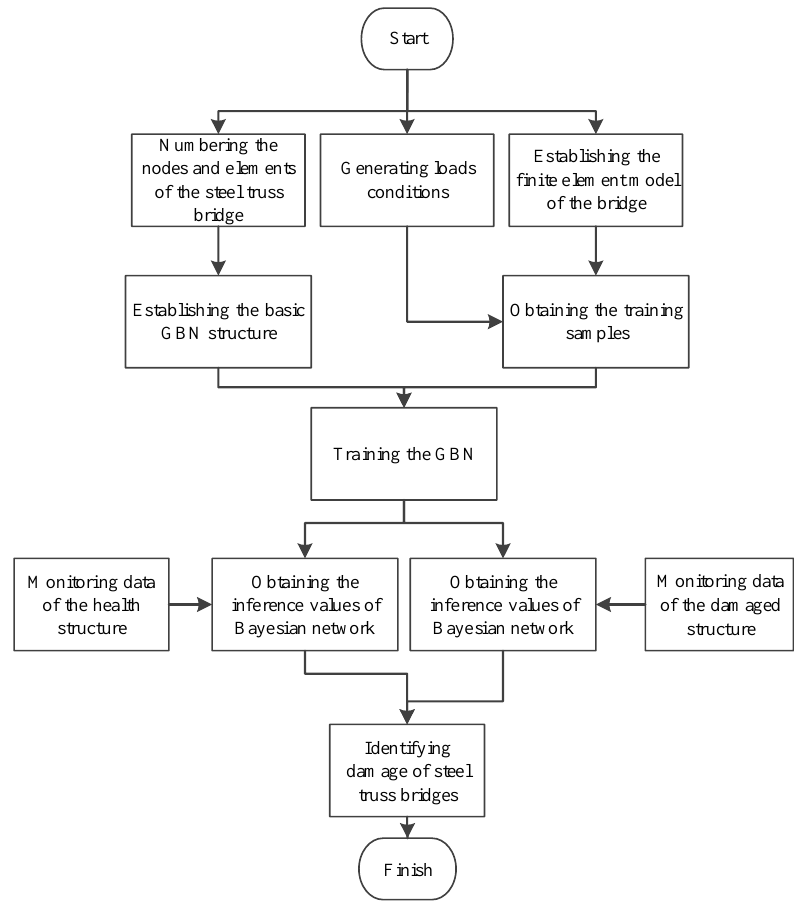
Figure 2. Damage detection flow chart of steel truss